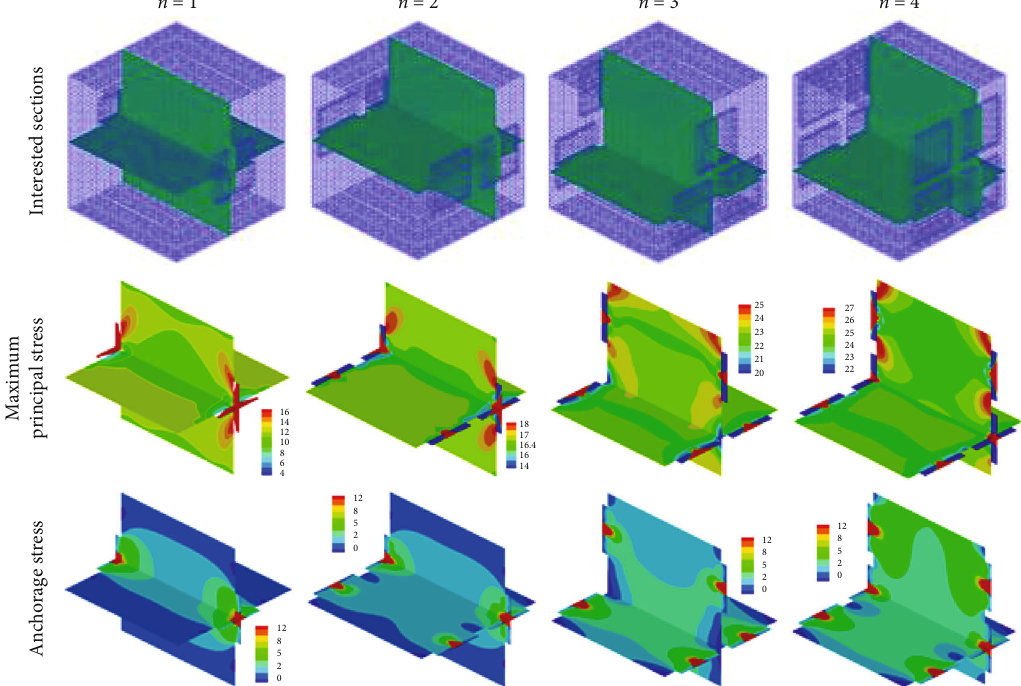
Figure 8: Maximum principal stress and anchorage stress distributions of rock mass specimen with di ff erent bolt